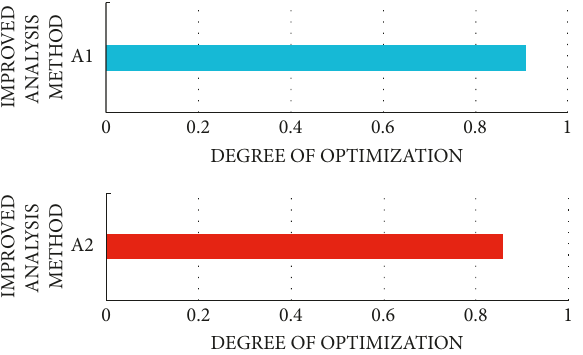
Figure 8: Optimization